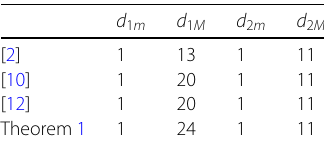
Table 1 Allowable time-delay upper bounds d 1